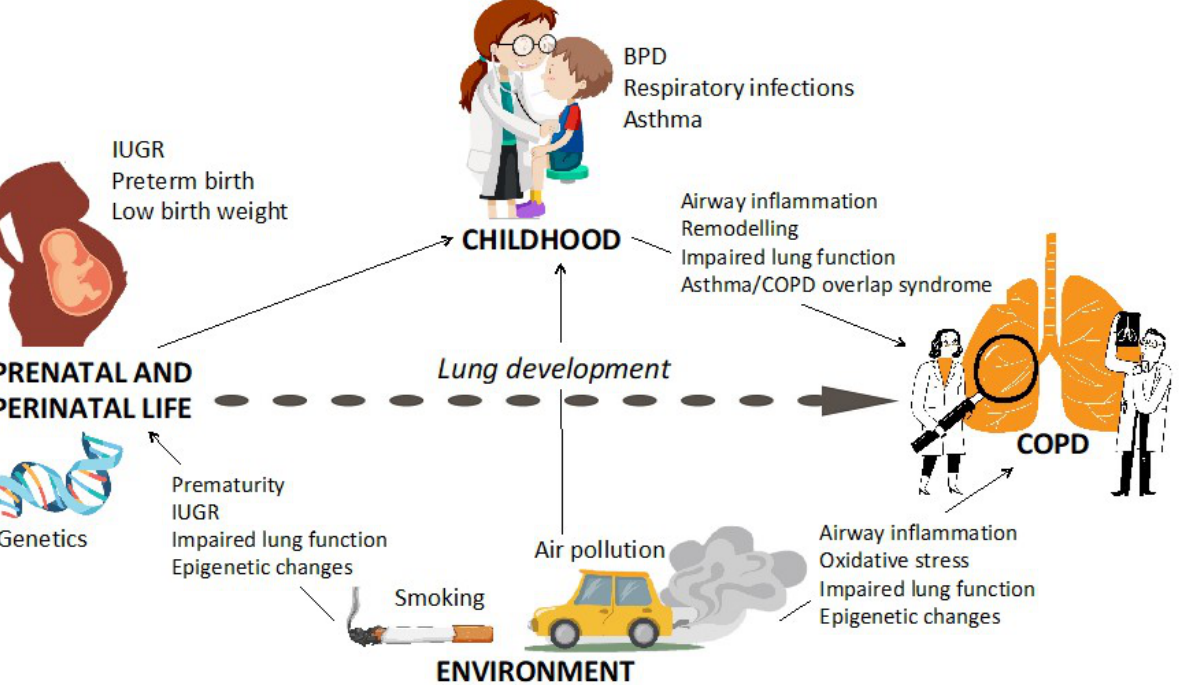
Figure 4. Factors in prenatal and perinatal life, the environment, and childhood affecting the risk of developing COPD in adulthood. IUGR, intrauterine growth restriction; BPD, bronchopulmonary dysplasia; COPD, chronic obstructive lung